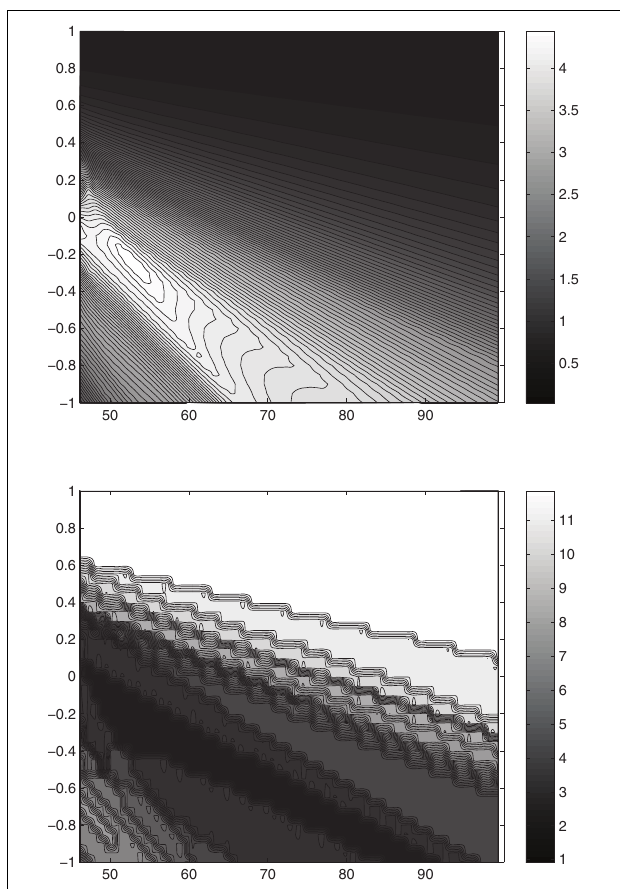
FIGURE 9 | Above: Sum of the p -values, depending on the transformation parameter λ and the offset. Below: Number of rejected hypotheses of Gaussianity at 10% significance level, depending on the transformation parameter λ and the